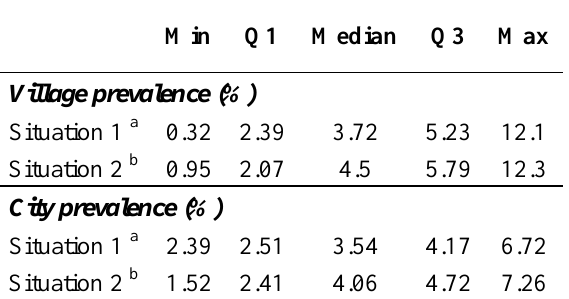
Table 4. Bayesian prevalence estimates (posterior median) of S. japonica infection within villages and cities, respectively, in the survey of S. japonica in Hubei Province, China,